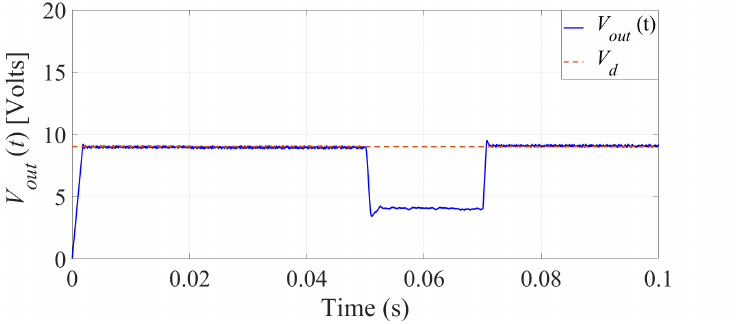
Figure 10. Scenario 1: Output voltage ( V out ( t ) ) implementing the proposed nonlinear PID